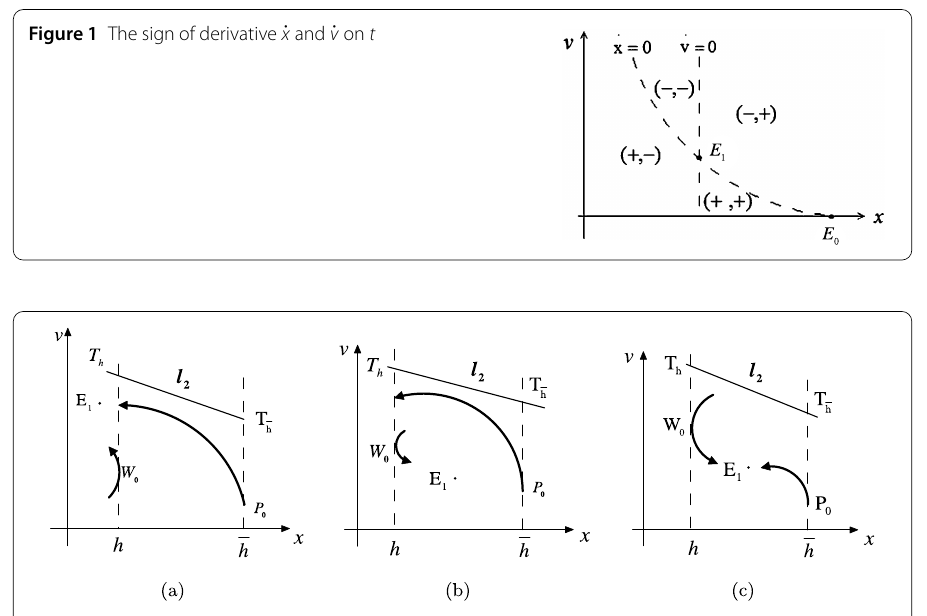
Figure 1 The sign of derivative ˙ x and ˙ v on t